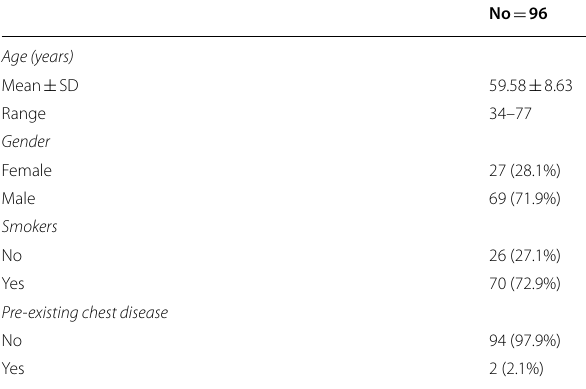
Table 1 Demographic data of studied population Table 2 Baseline investigation and laboratory work up